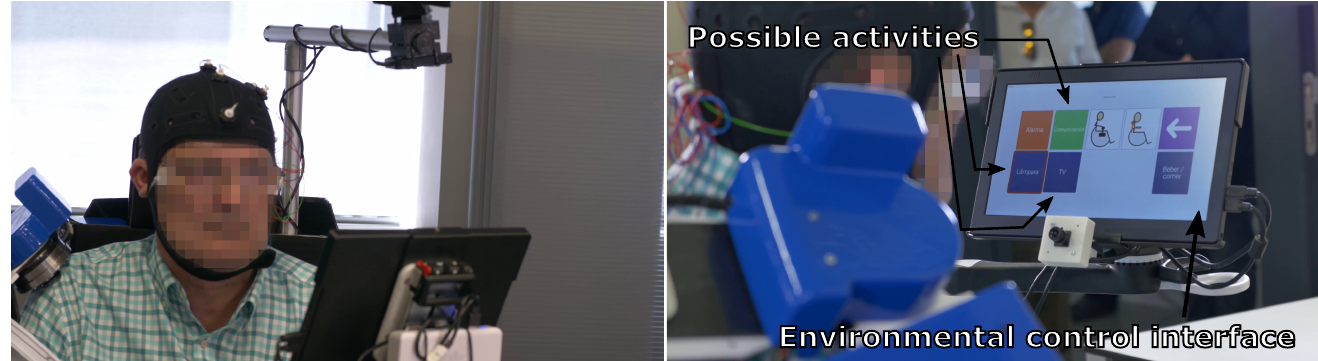
Figure 8. Images of the experimental session where the user navigates through the menus of the control interface to perform the different tasks of the protocol.